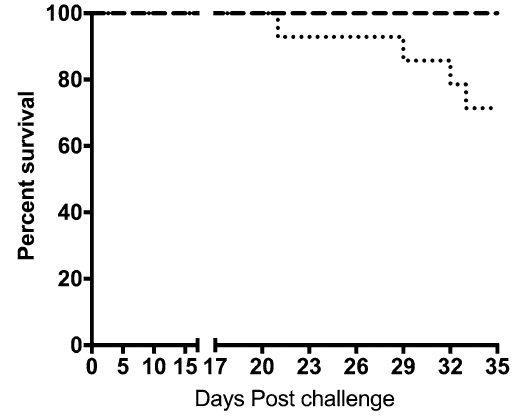
Figure 1. Survival curve for the challenged group (dotted line) and controls, giving a 71.5% survival (38.5% mortality) in the challenged